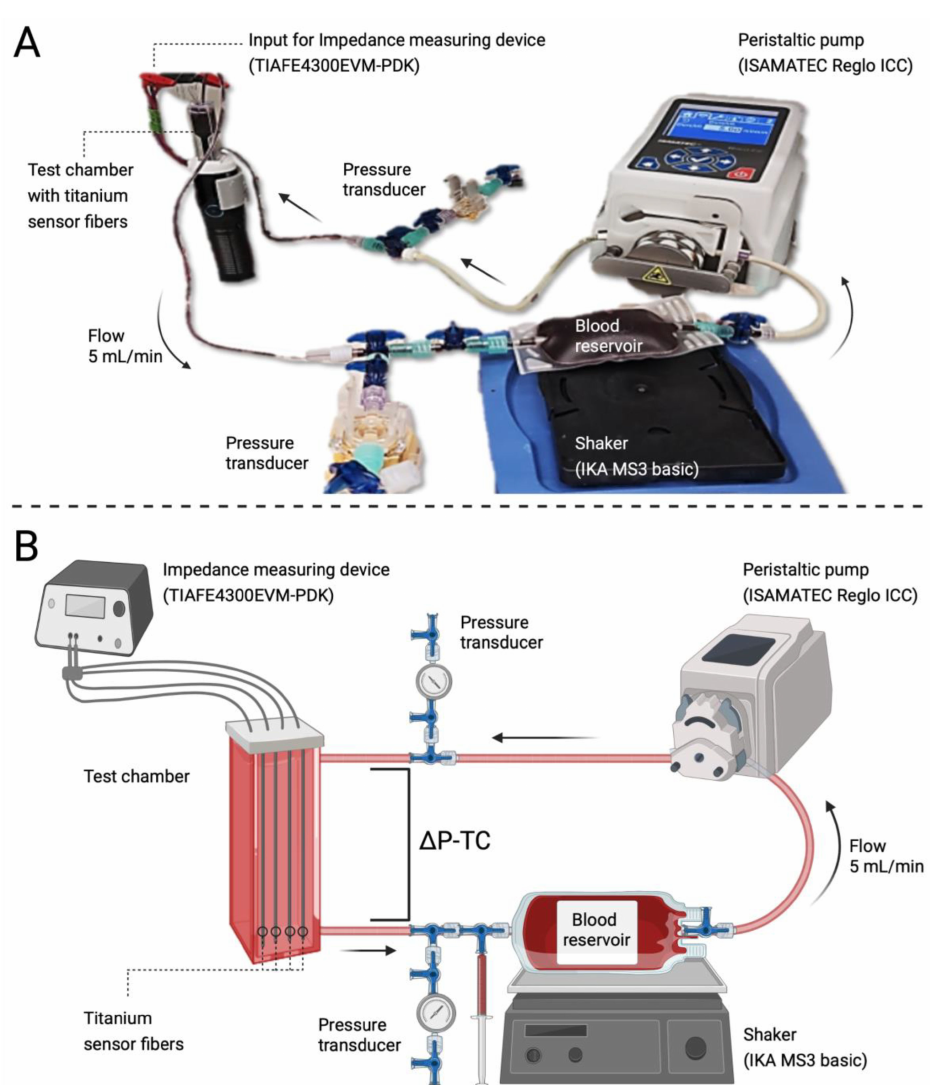
Figure 2. Image of the actual test circuit ( A ) and a schematic view of the test circuit ( B ). ∆ P-TC: Pressure difference across the test chamber. The syringe indicates the location of blood sampling. Created with